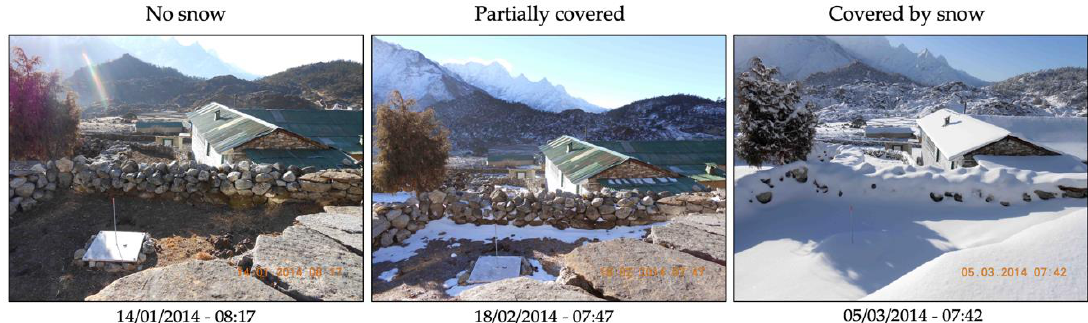
Figure 4. Snapshot examples of snow cover extent and height measurements at the Khunde site.